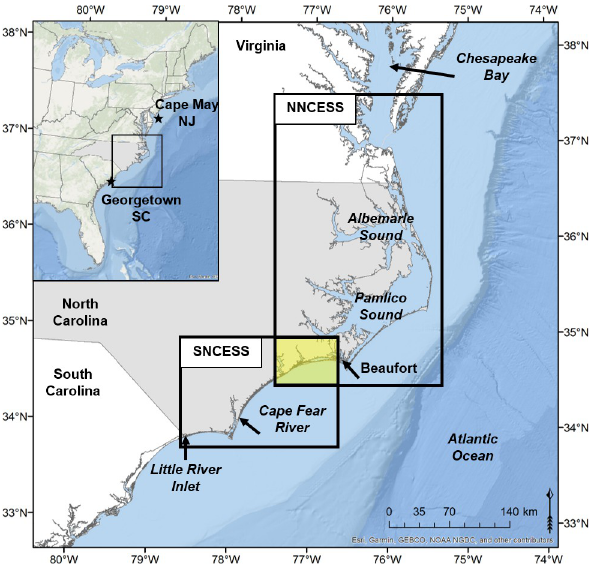
Fig 1. Geography of the North Carolina coast and stock boundaries for the two designated estuarine-resident bottlenose dolphin stocks. The two boxes labelled NNCESS (Northern North Carolina Estuarine System Stock) and SNCESS (Southern North Carolina Estuarine System Stock) indicate the currently defined range, across all seasons, of the two estuarine-resident stocks of bottlenose dolphins in North Carolina. The yellow-shaded area indicates an area of overlap for the two stocks. During some months, the stock definitions have the two stocks sympatric in this area. The long-term photo-ID catalog contains identified dolphins photographed from Cape May, NJ, to Georgetown, SC.